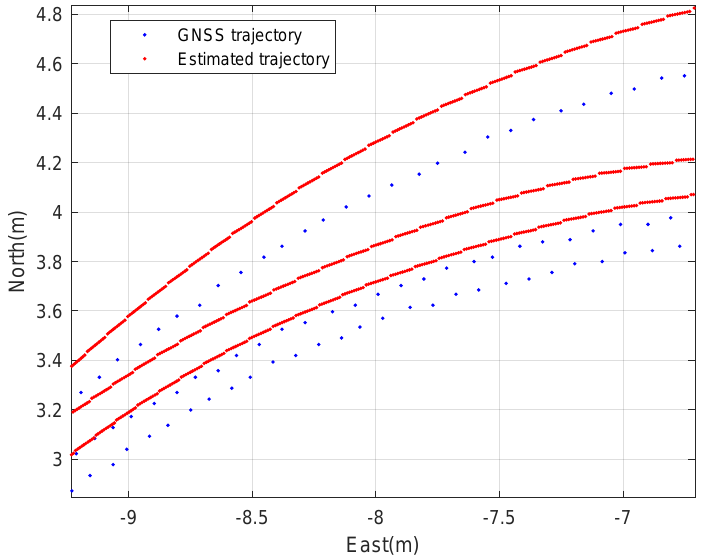
Figure 7. The expanded 2D trajectory of the rover: a circular driving test. Figure 8 shows the speed of the circular driving rover. The blue dots represent the measured GNSS speed data and the red dots represent the estimated speed using the designed integration filter. The speed of the rover is estimated as 1 m · s − 1 using the designed integration filter and the deviation of the integration result is much smaller than that of the GNSS speed data as shown in Figure